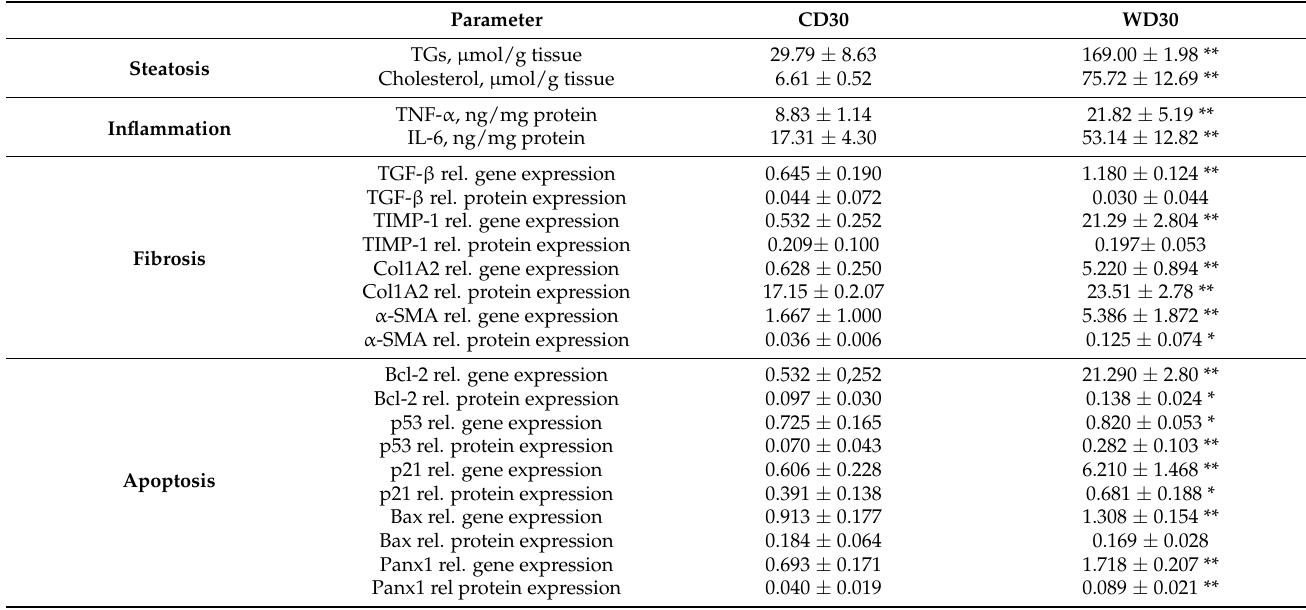
Table 2. Parameters of liver steatosis, inflammation, fibrosis, and apoptosis in mice fed a control diet (CD30) and Western- style diet (WD30) for 30